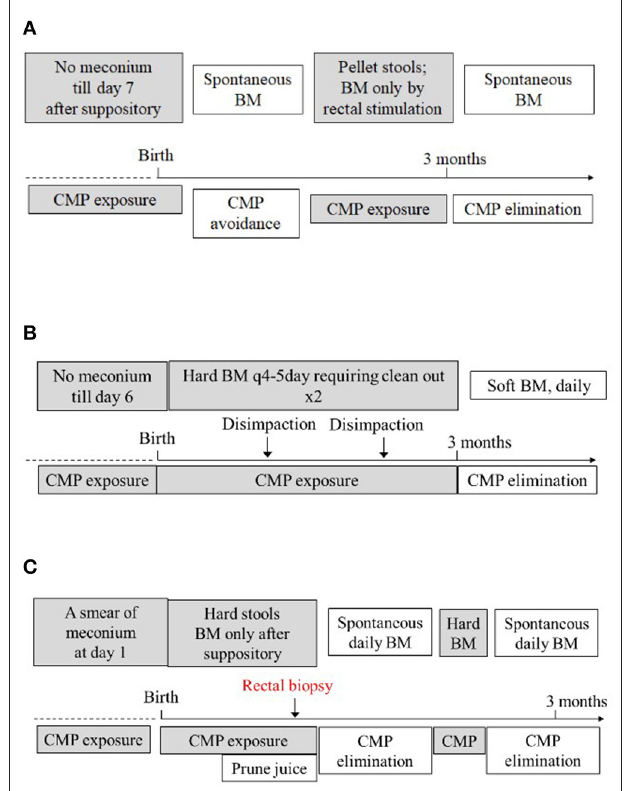
TABLE 1 | A summary of the age demographics and systemic and gastrointestinal symptoms of the three cases. Post-menstrual age at birth